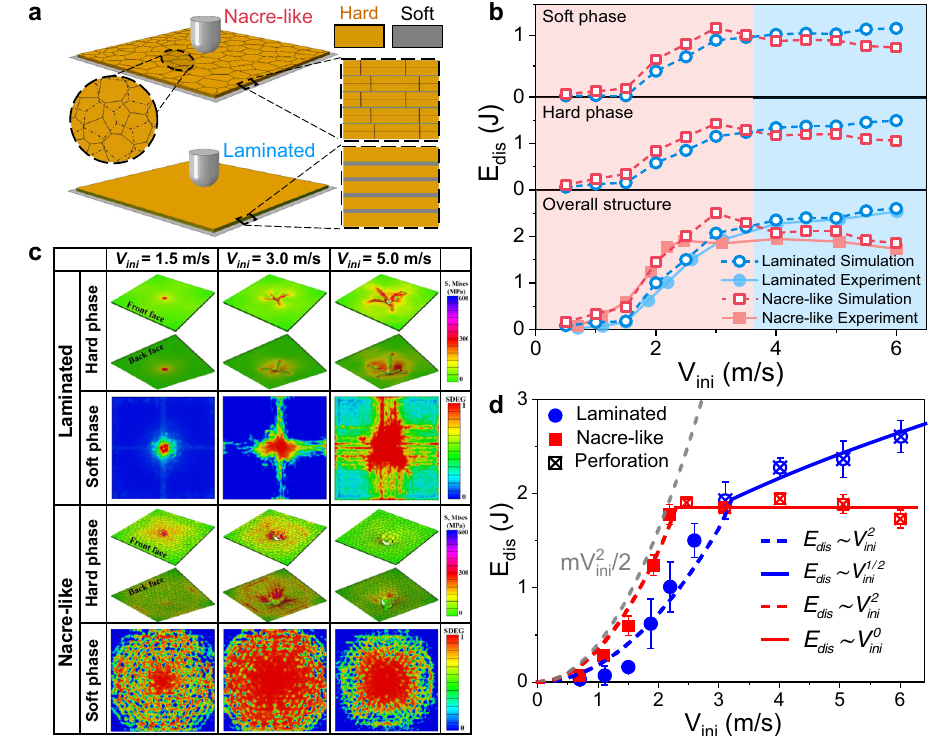
Fig. 4 | Analysis of the critical impact velocity. a Finite element model for the nacre-likeandlaminatedstructuresunderimpactloading. b The E dis – V ini curvesfor the overall nacre-like structures, the overall laminated structures, the hard phases and the soft phases in the nacre-like and laminated structures. c The deformation maps for the softlayers(scalar stiffness degradation variable (SDEG) fi eld) and the